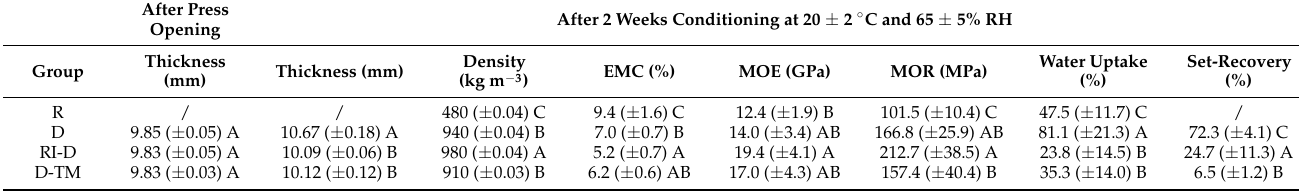
Table 2. Physical and flexural properties of untreated and treated